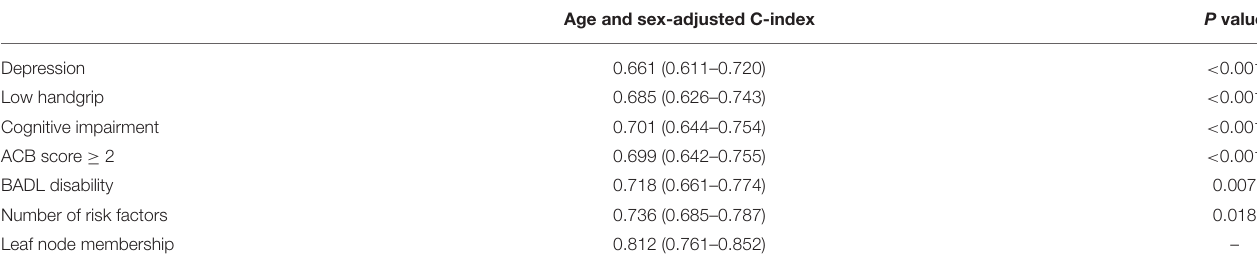
TABLE 3 | C-index in predicting 1-year mortality obtained by leaf nodes membership from survival tree analysis compared to individual risk factors or number of risk